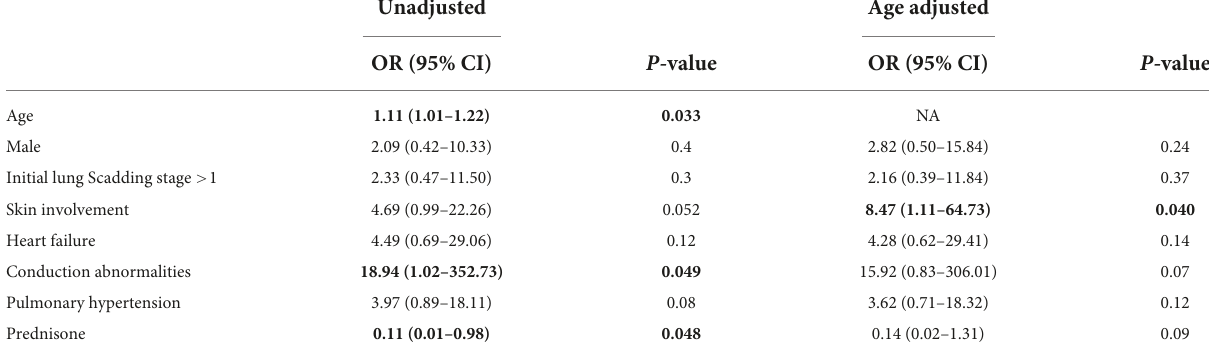
TABLE 3 Association between important baseline factor and mortality ( N =